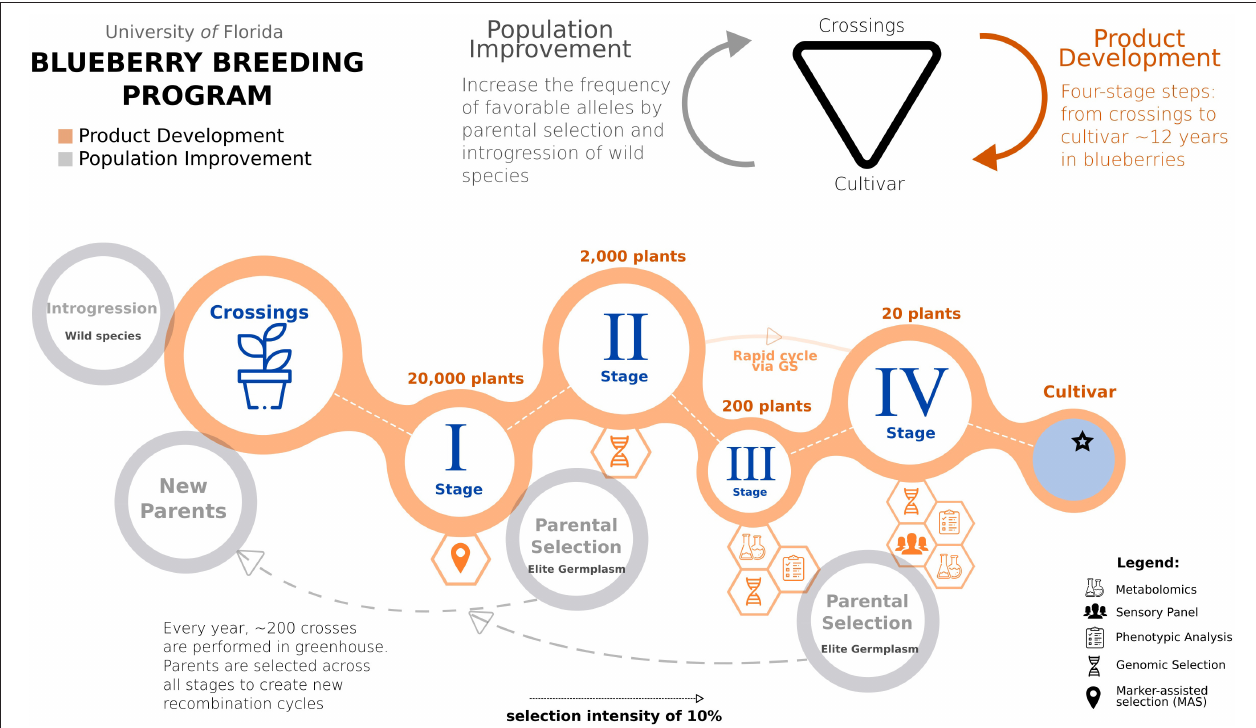
FIGURE 2 | A schematic representation of the UF blueberry breeding program, integrating phenotypic selection and genomic prediction. The breeding process is conventionally organized in two integrated steps: population improvement and product development. A breeding cycle starts with crosses between outstanding parental genotypes. After that, several stages (I–IV) are required to evaluate the genotype performance. At Stage I, we will use marker-assisted selection targeting traits with simple genetic architecture. Genomic selection will be implemented in Stage II when GEBVs are computed. In advanced selections (Stages III and IV), high-quality phenotyping will be performed to leverage the calibration of genomic prediction models. At these stages, metabolomics and sensory panel analyses will also play an important role in flavor-assisted selections. In the end, elite materials are registered as clonally propagated cultivars. In addition, to shortening the time for product development, GS can be applied to move top-ranked plants directly from Stages II to IV, skipping at least 3 years of evaluation at Stage III. For population improvement, GS can assist in more accurate parental selection at early